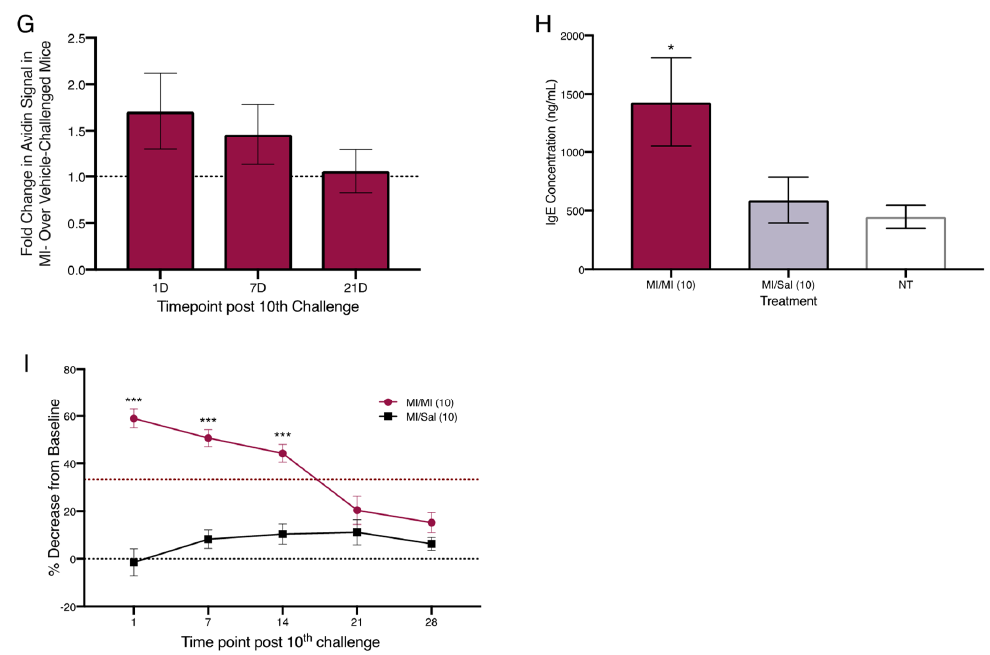
Figure 3. Increased mast cell density in the vaginal canal and elevated tactile ano-genital sensitivity after 10 intra-vaginal MI challenges in previously sensitized ND4 female mice. Representative confocal images of vaginal canal tissue from MI sensitized mice challenged with MI ( A – C ) or saline D – F ) at 1, 7, and 21 days after the 10th MI challenge, respectively. Mast cells stained with FITC-conjugated avidin (green) and nuclei counterstained with DAPI (blue); 200 × magnification. ( G ) Density of avidin + mast cells in 12 µ m vaginal canal cryo-sections from sensitized mice challenged with MI or saline. Results reported as fold change in avidin signal in MI- over saline-treated mice. Dotted line denotes no change. Data pooled from 5–6 mice. ( H ) Serum IgE content in mice treated with MI or saline in the vaginal canal 1 day after the last MI / saline challenge. NT bar denotes serum IgE levels in naïve age-matched, untreated mice. Significance with respect to vehicle control group * = p < 0.05; 4–6 mice / treatment group. ( I ) Tactile sensitivity in MI and saline challenged mice, reported as mean ± SEM of the percent decrease from baseline in the withdrawal threshold for each treatment group; n = 17–18 mice / treatment group. Red dotted line = 33% hyperalgesia threshold. Significance with respect to vehicle control group *** p <